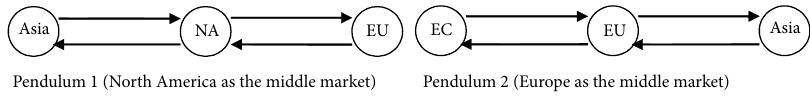
Pendulum 1 (North America as the middle market)